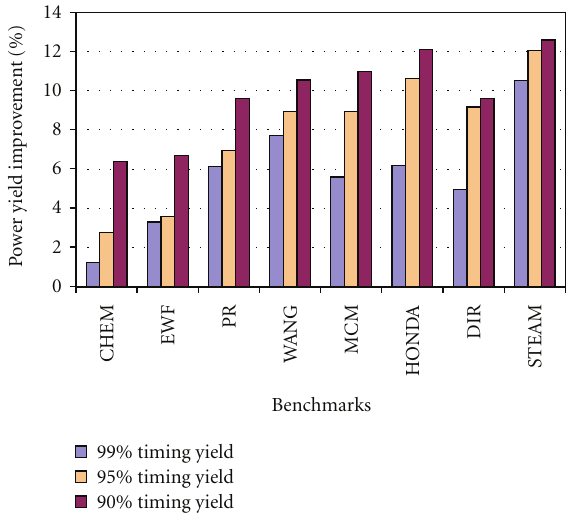
Figure 14: Power yield improvement against deterministic worst- case approach with multi- V th only and di ff erent timing yield con- straints. Table 2: The Overheads of voltage level converters.